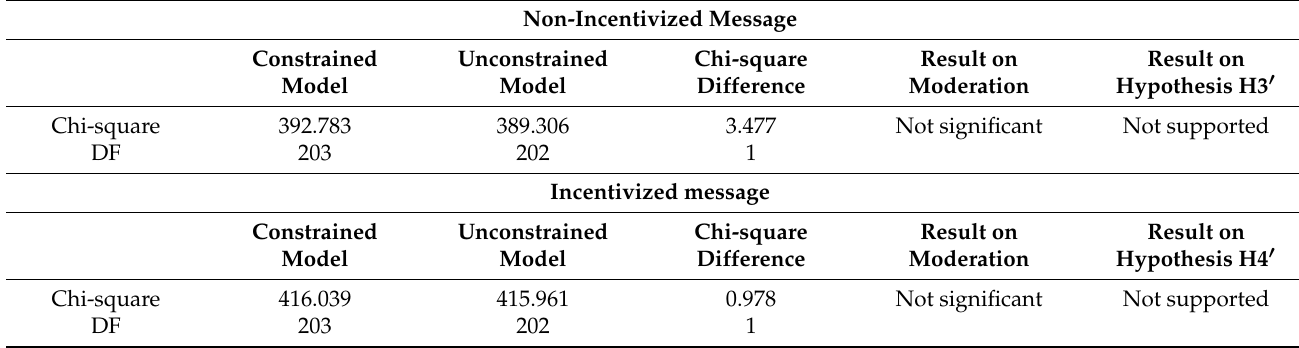
Table 8. Moderation test of the message type in the relationship between perceived source expertise and message credibility.